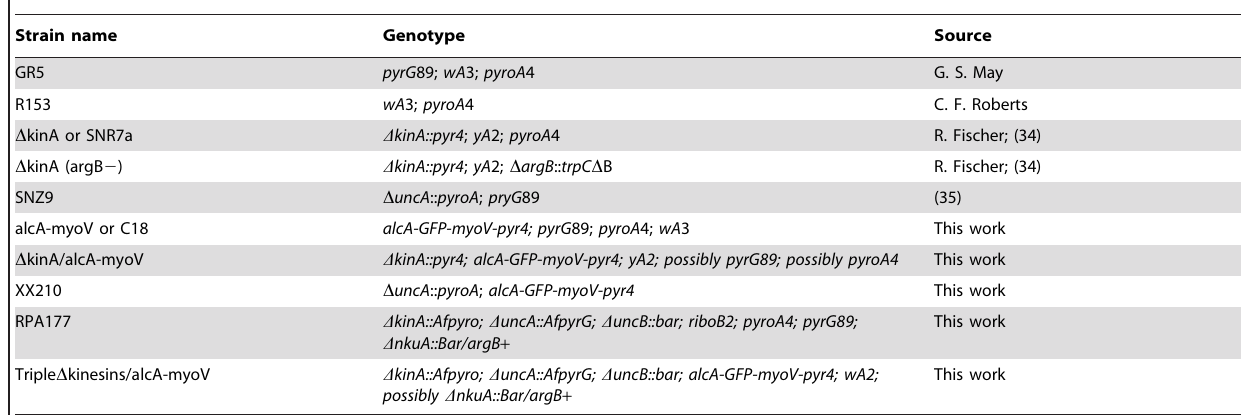
Table 1. A. nidulans strains used in this